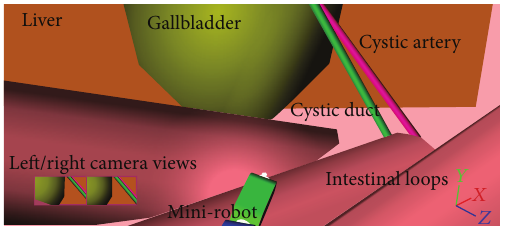
Figure 3: The intra-abdominal environment was simulated by simple 3D structures representing the intestine, the liver, and the gallbladder. On the lower left corner of the figure, the mini-robot’s onboard camera views are shown. The gallbladder is suspended by a grasper like mini-robot (refer to